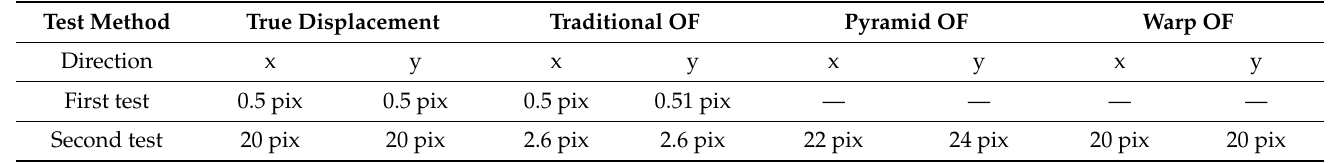
Table 3. Specifications of the high-speed FASTEC IL5 camera